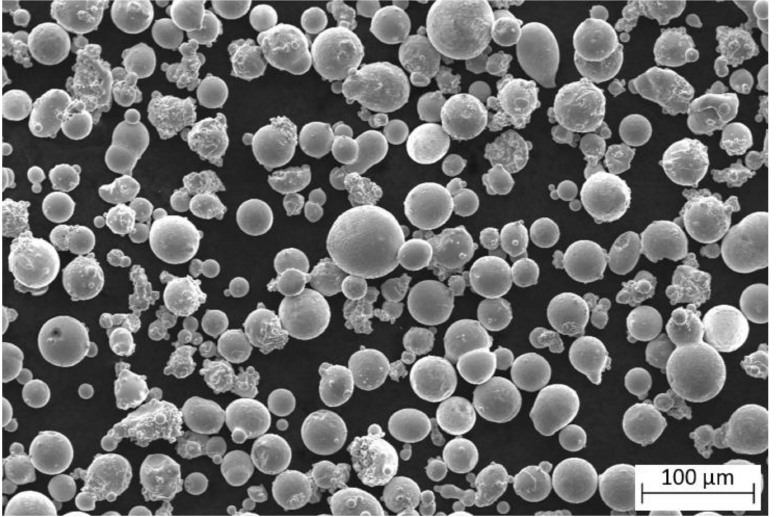
Figure 1. IN625 powder morphology observed via